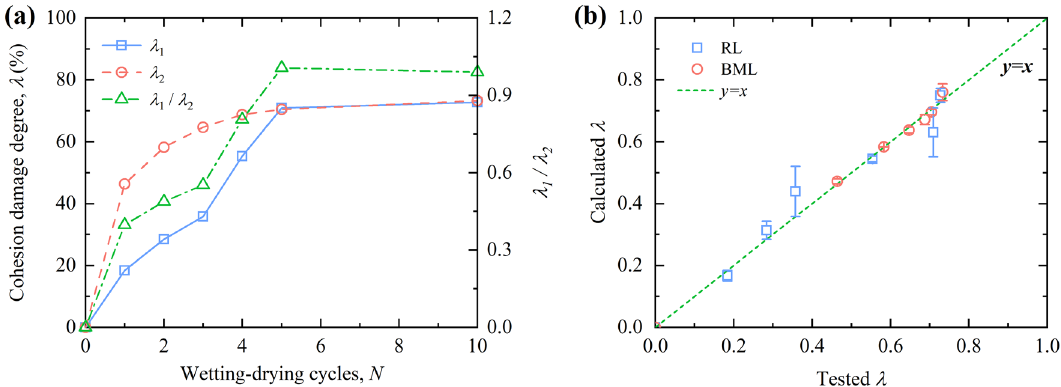
Figure 14. Comparison of cohesion damage degree and model